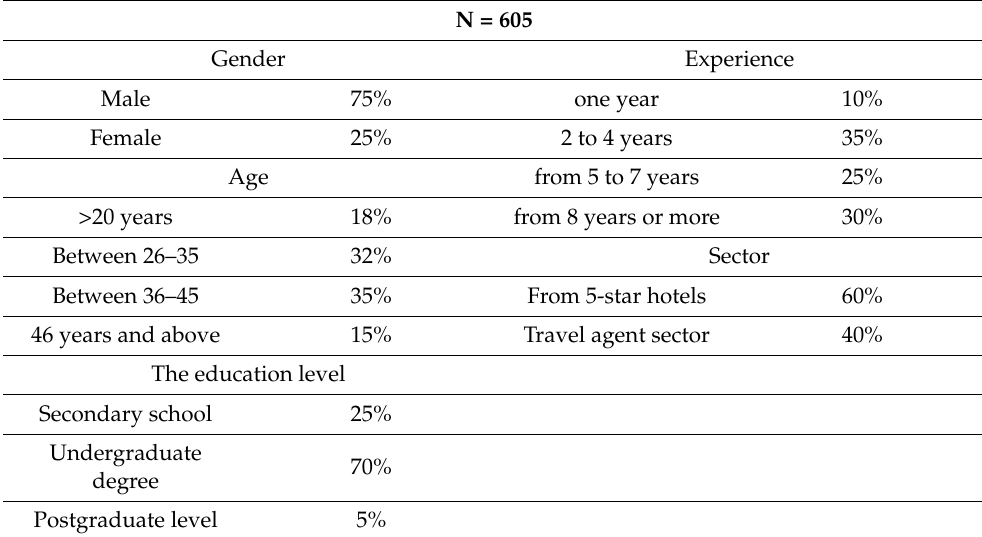
Table 1. The employees’ characteristics.